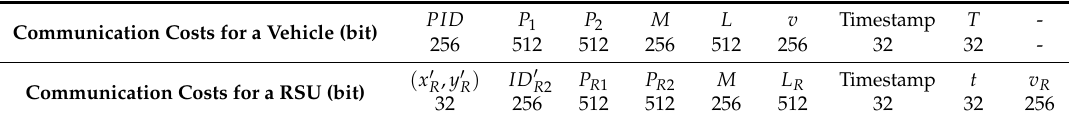
Table 5. Communication costs of the proposed scheme.